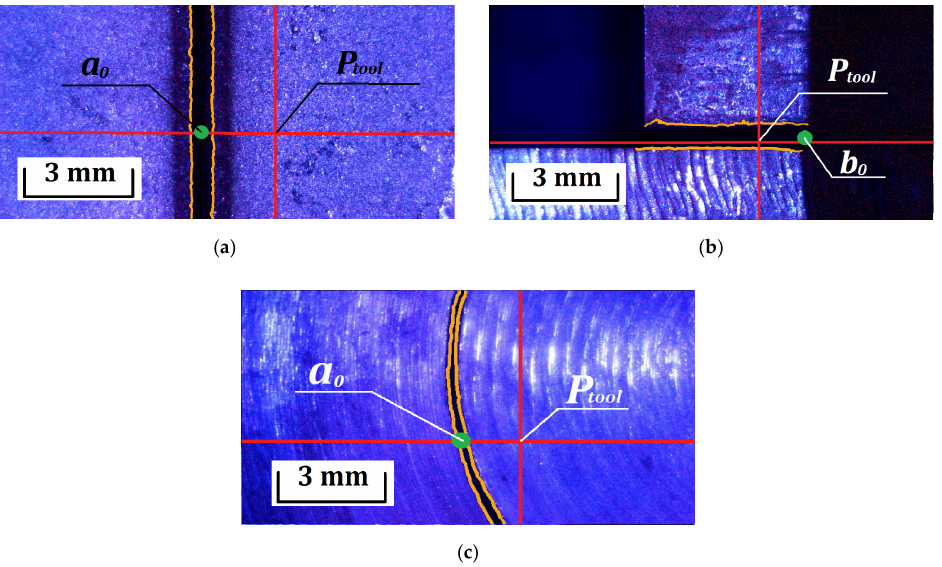
Figure 17. The result of determining the correction point in the case: ( a ) part gap along the frame; ( b ) full gap in the frame; ( c ) arc-shaped gap in the frame.